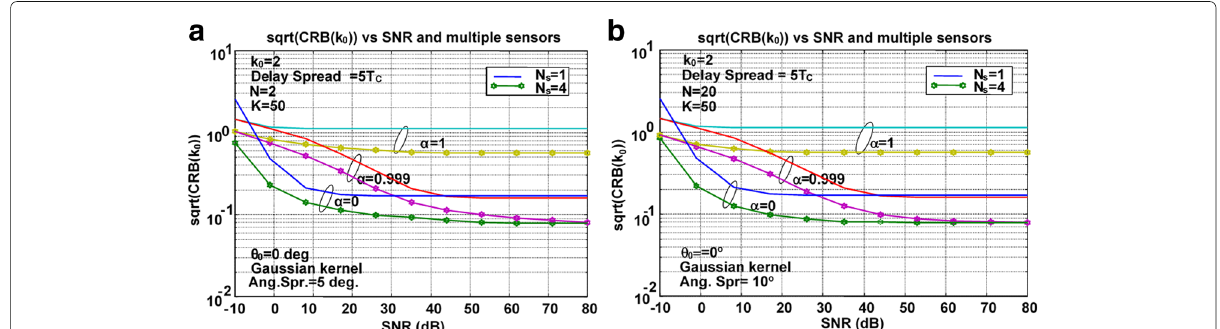
Fig. 4 CRB of the first arriving path k 0 for different values of the SNR. Results are provided for different values of the temporal correlation α and different angular spreads for the received signal. The number of sensors is 1 (solid) and 4 (solid bullet). Delay spread set to 5 T c , for 50 channel vector estimates. a Left: angular spread set to 5°. b Right: angular spread set to 10°